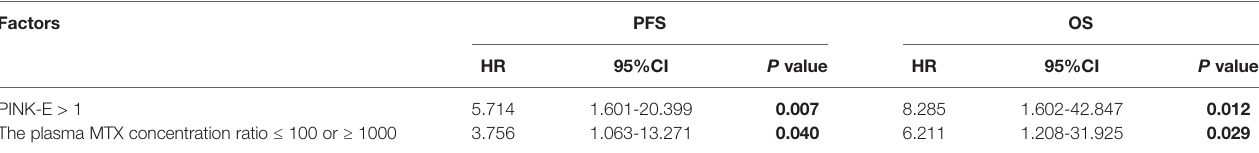
TABLE 4 | Multivariate analysis of prognostic factors for both PFS and OS.